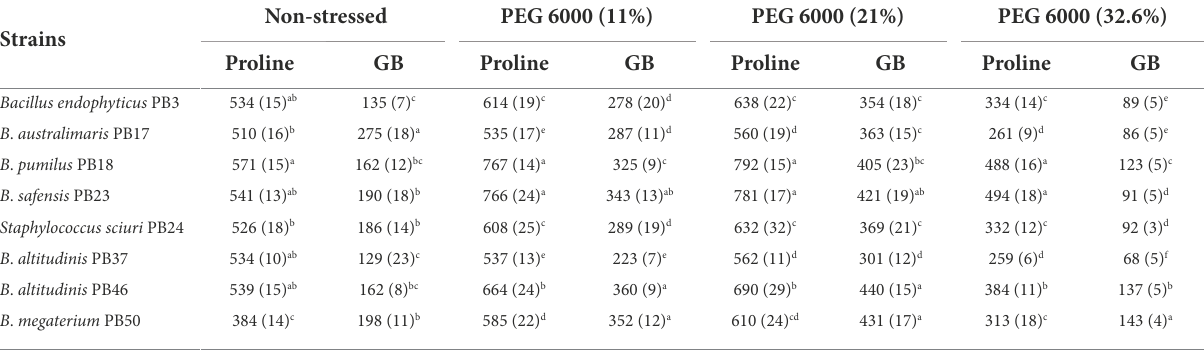
TABLE 5 Mean and standard deviation values of proline and glycine betaine (GB) accumulation ( μ g ml − 1 ) by each rice phyllosphere bacterial strain (number of replicates, n = 3) measured under three different osmotic stress conditions and a non-stress condition.